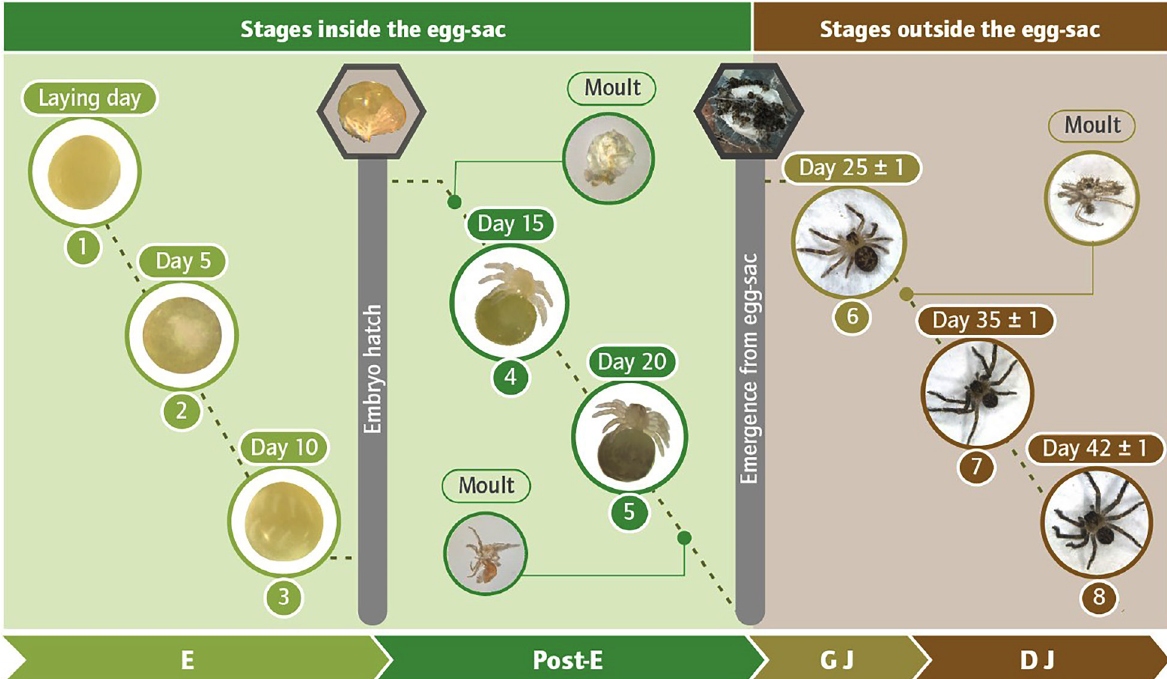
Figure 1. The analysed stages of P. pythagoricus development. Inside the egg-sac: the embryonic period (Stages 1 to 3) and post-embryonic period (Stages 4 and 5); Outside the egg-sac: juveniles in gregarious stage (Stage 6) and juveniles in dispersal stages (Stages 7 and 8). E: embryonic period; Post-E: post-embryonic period; GJ: juveniles in gregarious stage; DJ: juveniles in dispersal